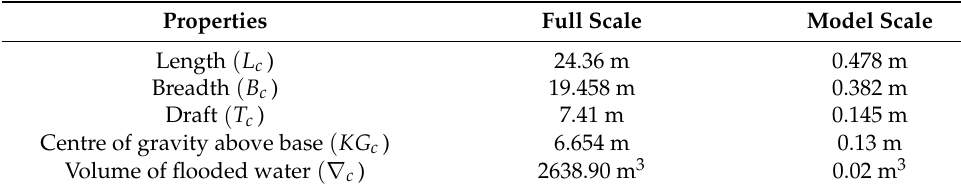
Figure 5. Geometry of the damaged compartment. Table 2. Parameters for the damaged compartments.